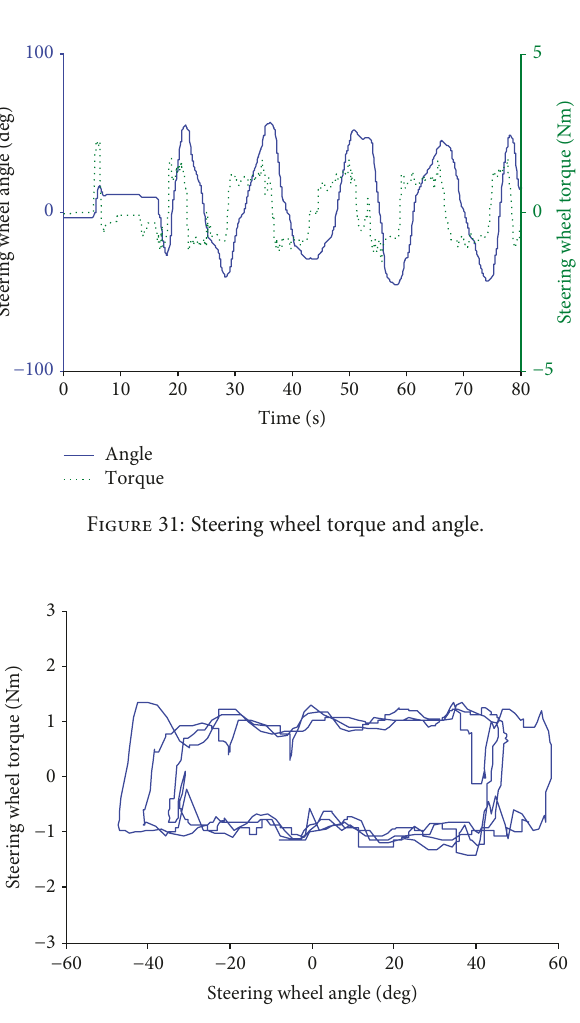
Figure 32: The relationship between steering wheel torque and angle.